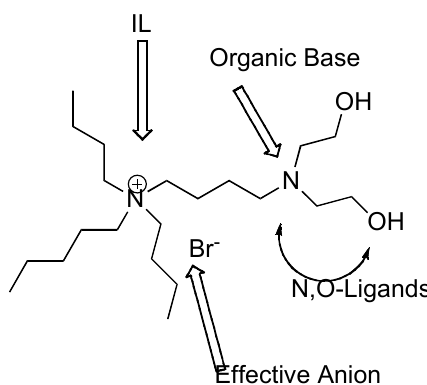
Figure 11. Multifunctionalized IL.